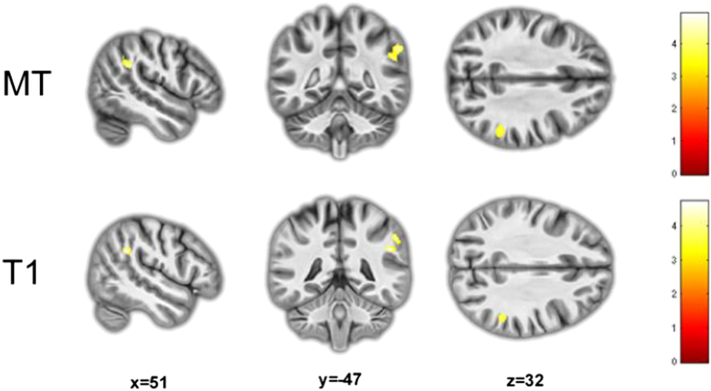
Right inferior parietal volumetric reductions in ADHD detected using MT saturation maps (p unc. < 0.001; FDR < 0.05). The same reductions are detected in T1 images (p unc. < 0.001) but clusters (p unc. = 0.027; p unc. = 0.078) did not survive FDR correction.